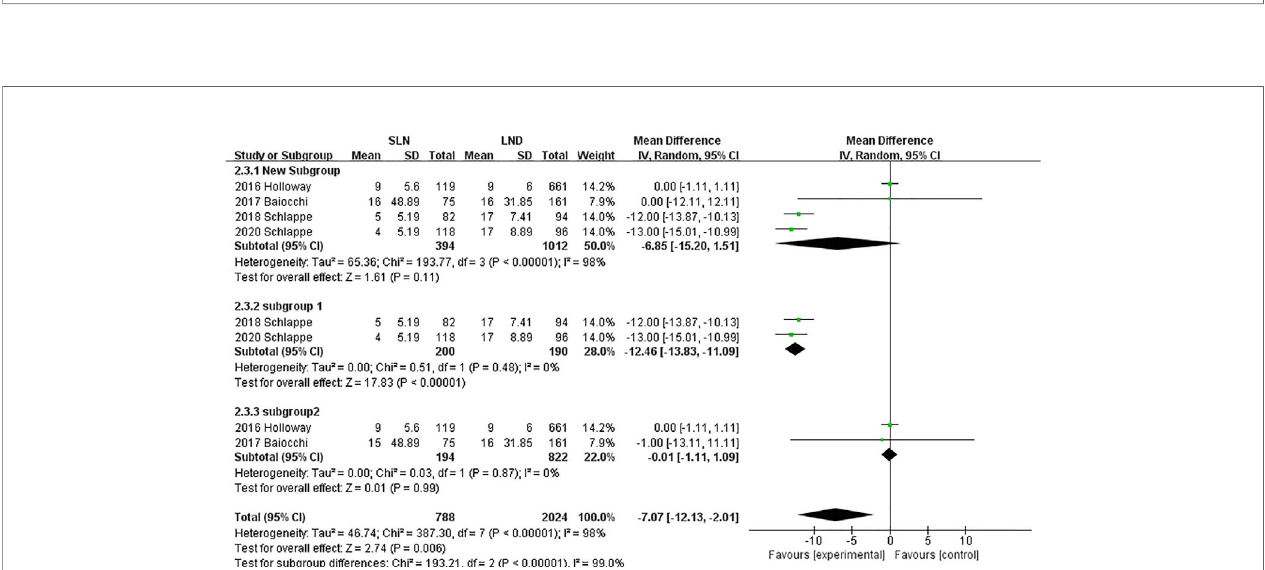
FIGURE 10 | TSA of pelvic lymph nodes removed, a = 0.05, b = 0.8, two-sided